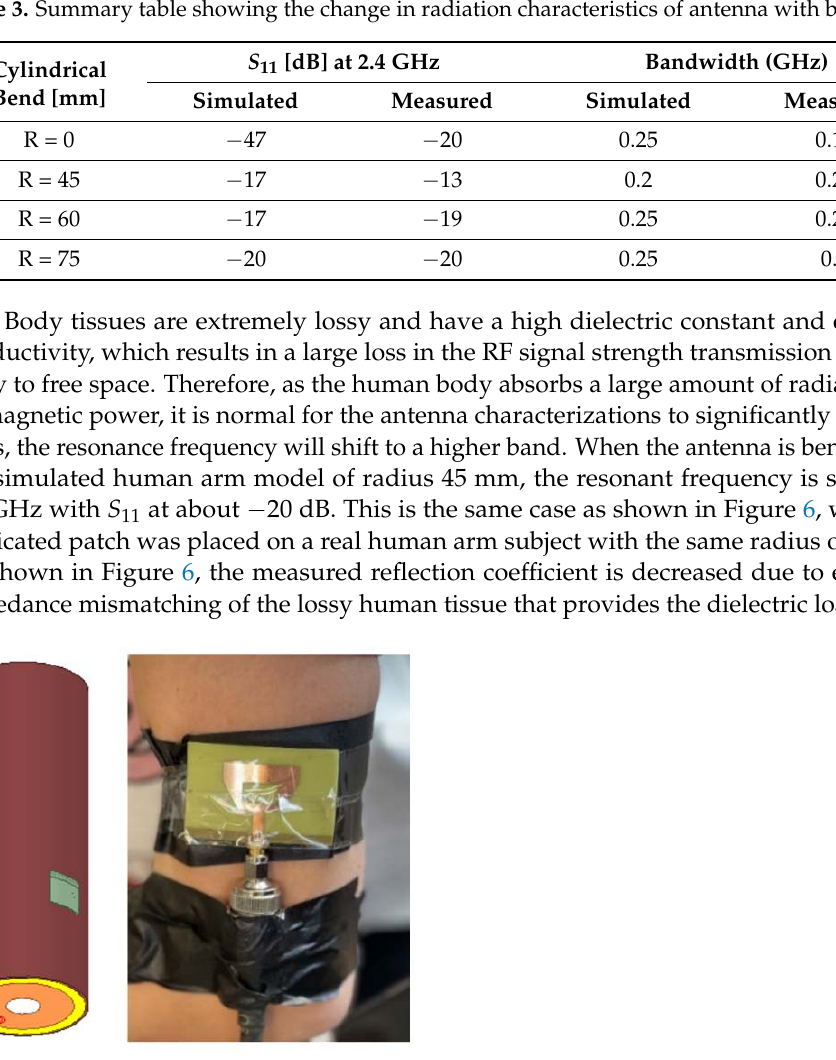
Figure 7. Simulated return loss with the presence of the simulated human arm model versus meas- ured return loss on a real human arm of the same radius 45 mm as simulated. According to [15], antenna bending will induce a shift in resonant frequency. More- over, additional shift will occur in the presence of a human body [16]. Furthermore, though the resonance was obtained at 2.6 GHz (Figure 7) near the arm with maximum bending and the design was optimized at narrow band 2.4 GHz in free space without bending, the study relies on obtaining the scattering parameters S21 of the two antenna pairs over [2,3] GHz. The dielectric properties of the human arm phantom were updated each time the frequency of the antenna is varied over [2,3] GHz because they are frequency dependent [17] and are presented Figure 1. However, the measured results show some degradation in the performance of the antenna. Thus, for better results and as a future work, adding a layer with relative permit- tivity equal to the average permittivity of the arm tissue (skin, muscle and bone) and thick- ened equal to the average diameter of the human arm. In this case, the general results and accuracy will be improved. -25-20-15 -10 -5